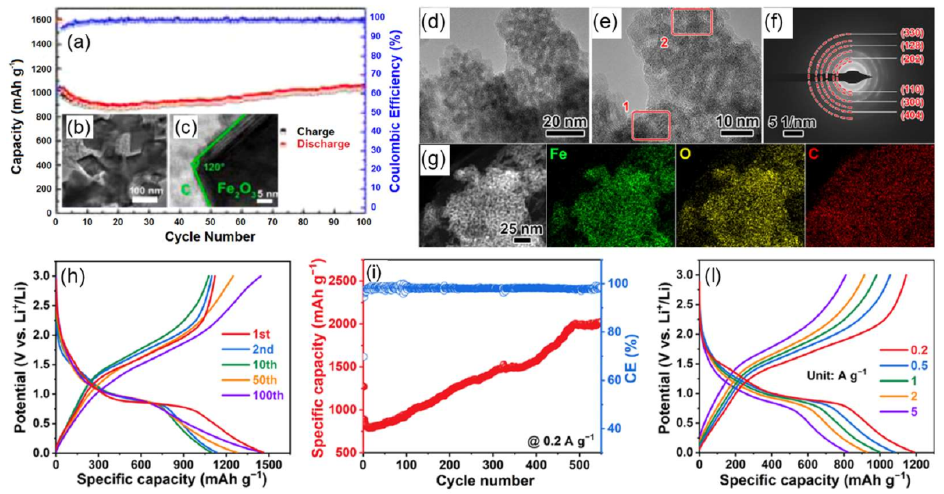
Figure 4. ( a ) Evolution of discharge–charge capacities and Coulombic efficiency for 100 galvanostatic cycles of Fe 2 O 3 @C composite with octahedron-like Fe 2 O 3 particles [46]. The Fe 2 O 3 @C composite was cycled at 0.2 A g − 1 between 0.02 V and 3.00 V vs. Li + /Li. The octahedron-like shape of Fe 2 O 3 is highlighted in the inset showing two transmission electron microscopy (TEM) images ( b , c ) at low and high resolution of the Fe 2 O 3 @C composite, with respective scale bars of 100 nm ( b ) and 5 nm ( c ). ( d , e ) TEM images of iron oxide/carbon composite with ultrafine Fe 2 O 3 nanocrystals anchored on reduced graphene oxide (rGO) [47] and ( f ) associated selected area electron diffraction (SAED). ( g ) TEM image and related X-ray energy dispersive (EDX) analyses of the Fe 2 O 3 @C composite show- ing Fe (green), O (yellow) and C (red) elemental maps, respectively. The scale bar in ( g ) is 25 nm. ( h ) Galvanostatic discharge–charge profiles for some selected cycles of Fe 2 O 3 @C at 0.2 A g − 1 in a potential range of 0.01–3.00 V vs. Li + /Li. Note a capacity increase and a variation of the slope of the discharge–charge curves after 100 cycles. ( i ) Cycling performances of the Fe 2 O 3 @C nanocom- posite at 0.2 A g − 1 showing its capacity evolution and Coulombic efficiency over 550 cycles [48]. ( l ) Galvanostatic profiles of charge–discharge of Fe 2 O 3 @C obtained in correspondence with different current densities. Note that a high capacity of ≈ 810 mAh g − 1 was still accessible during cycling at 5.0 A g − 1 . Reprinted with permission from Refs. [46,47]. Copyright 2022